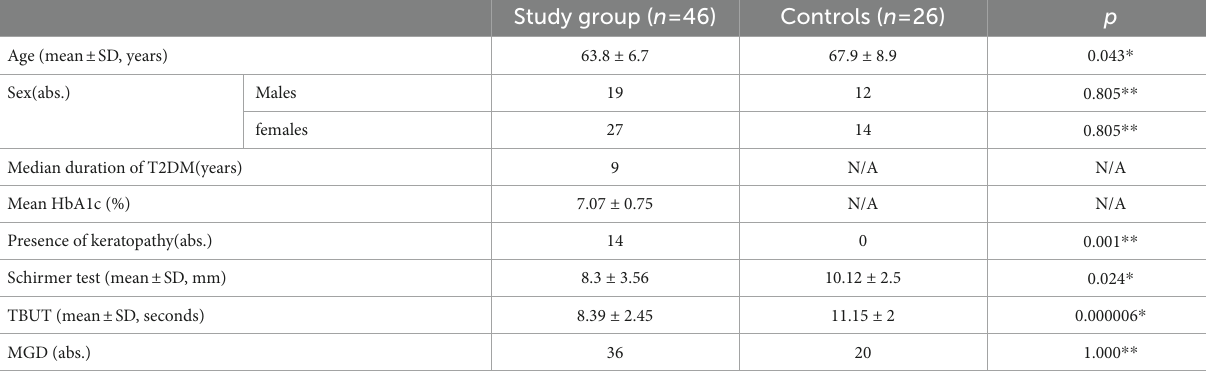
TABLE 1 Demographic and clinical characteristics of study and control groups.